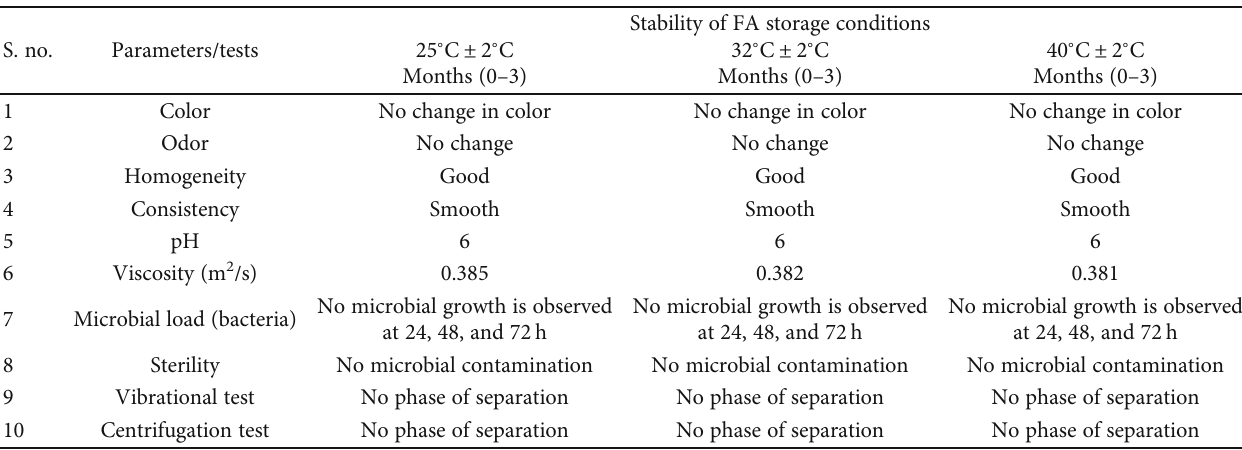
Table 2: Stability of FA.